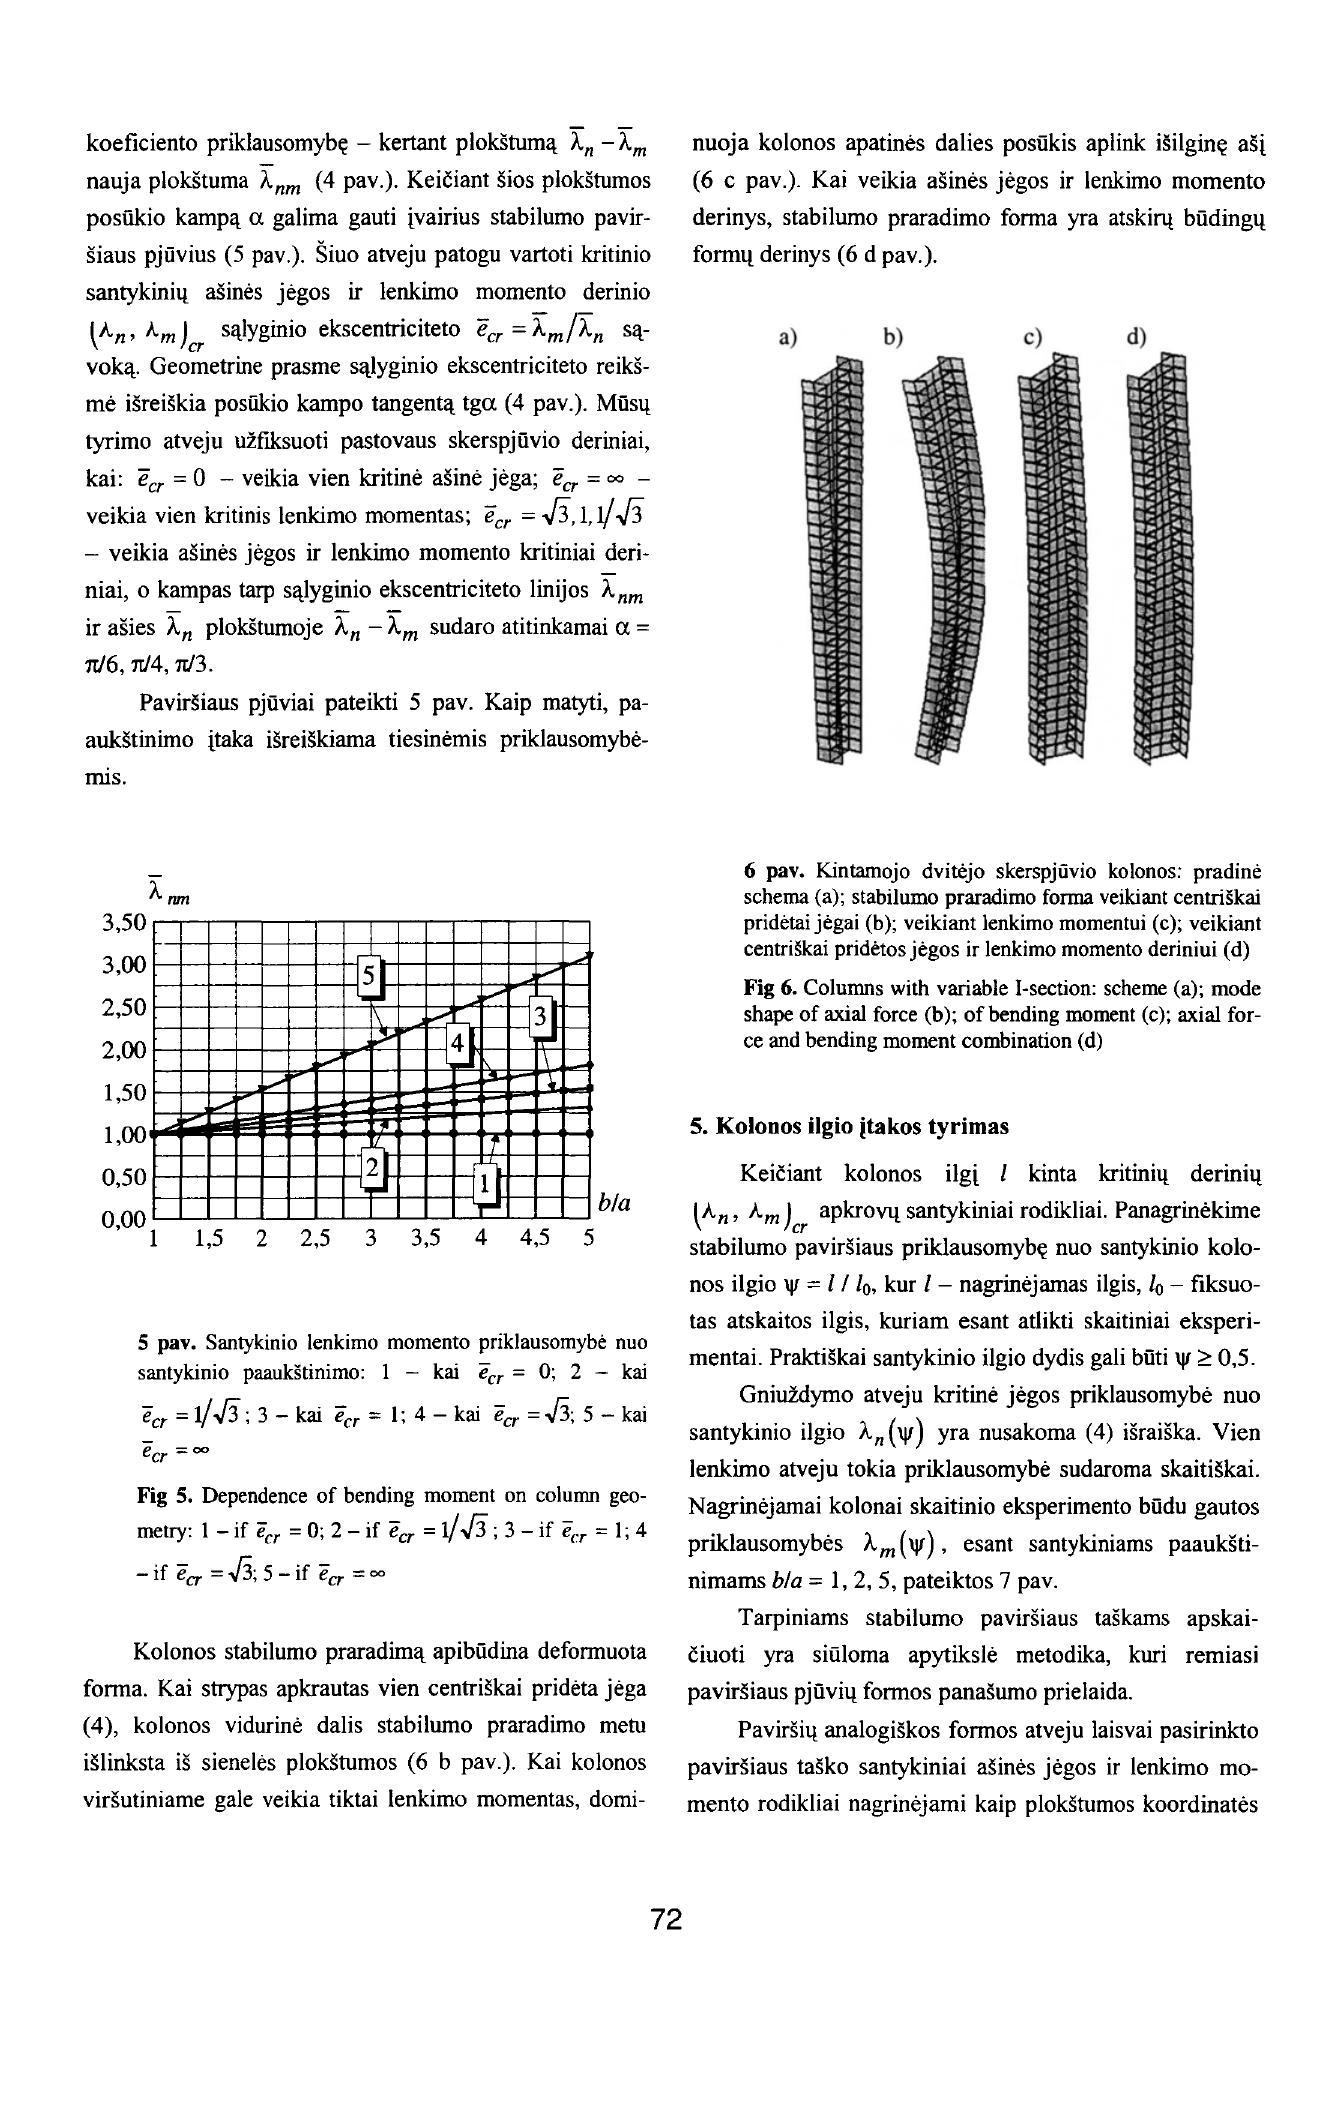
5. Kolonos ilgio itakos tyrimas Keiciant kolonos ilgi I kinta kritiniq deriniq tAn, Am )cr apkroVI.!_ santykiniai rodikliai.